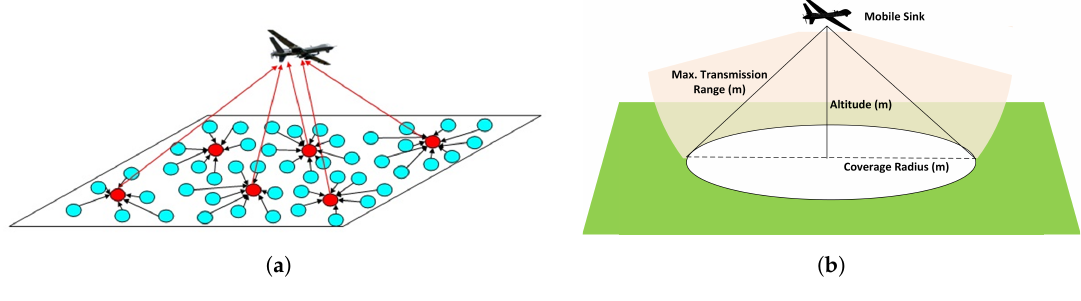
Figure 1. ( a ) Network Model; ( b ) Instant sweep (coverage) region of the unmanned aerial vehicle (UAV) [12].